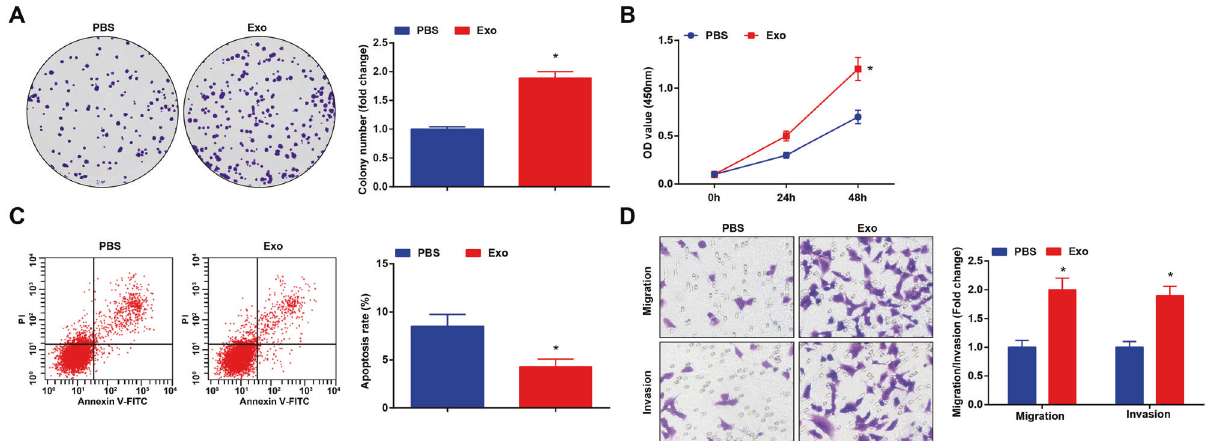
Fig. 2 CRCSC-exos promote malignancy of HCT116 cells. A Proliferation of HCT116 cells detected using colony formation assay after exosome treatment; B proliferation of HCT116 cells detected using CCK-8 assay after exosome treatment; C apoptosis of HCT116 cells detected using fl ow cytometry after exosome treatment; D migration and invasion of HCT116 cells detected using Transwell assay (magni fi cation: ×200) after exosome treatment. The cell experiments were repeated three times; * P < 0.05 vs the PBS group; the measurement data were expressed as mean ± standard